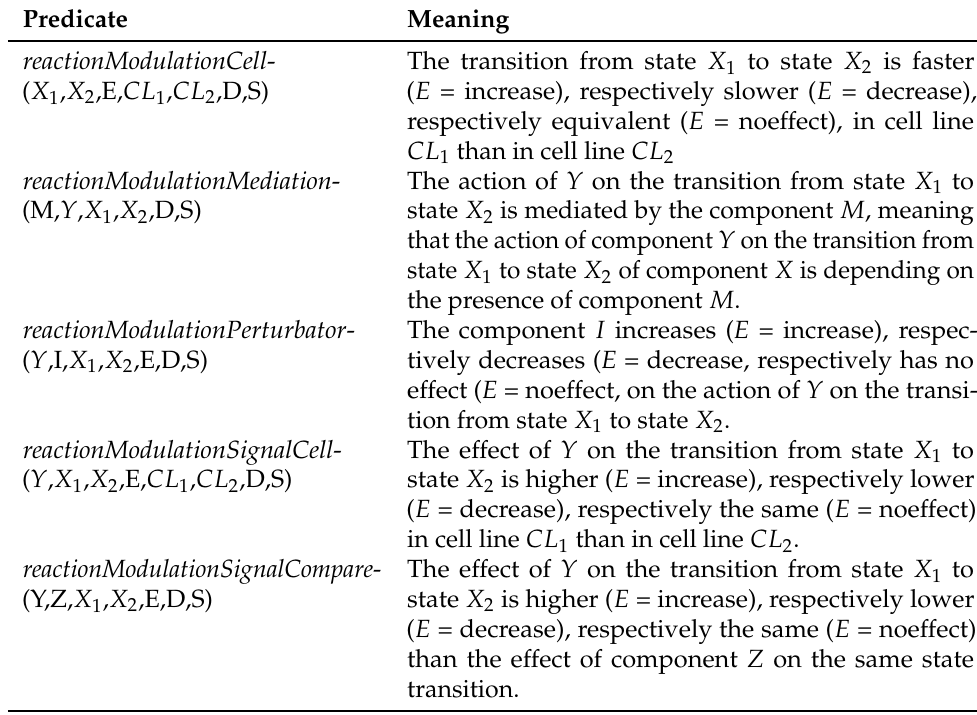
Table 1. Refinements of the root predicate reactionModulation . For the sake of clarity we omit the comment on D and S in the second column, as they always have the same